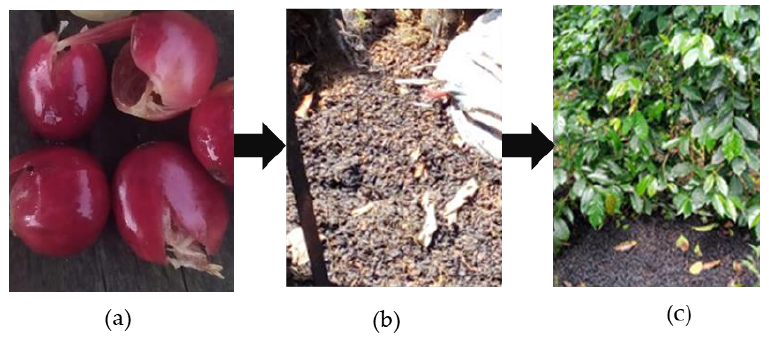
Figure 5. Coffee pulp biomass application. ( a ) Fresh coffee pulp as the co-product from the pulping process; ( b ) coffee pulp after a two-week waiting period before applying to the field; ( c ) coffee pulp application in a coffee plantation.